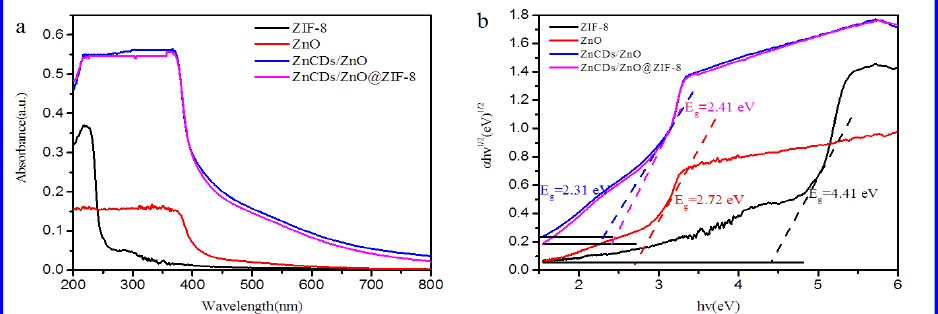
Figure 6. ( a ) UV-vis DRS ( b ) Kubelka–Munk function spectrum. The optical absorption properties of ZnCDs/ZnO@ZIF-8 and various related materials are shown in Figure 6a. All the absorptions occurred in the wavelength range of 200~400 nm. The observation indicates that the absorption intensity of ZnCDs/ZnO@ZIF-8 is higher than that of ZnO nanospheres and ZIF-8, respectively. The absorption ability in the visible-light region is enhanced as ZnCDs/ZnO enveloped by ZIF-8, which is conducive to the utilization of the solar spectrum. The band gap energies (E) of direct transition semiconductor can be calculated according to the plot of (ahv) 2 versus photon energy (hv) [41]. As shown in Figure 6b, the E g of ZnCDs/ZnO@ZIF-8 estimated to be 2.41 eV, which is narrower than that of ZnO (2.72 eV) and ZIF-8 (4.41 eV), respectively, owing to the incorporation of ZnCDs/ZnO with ZIF-8.